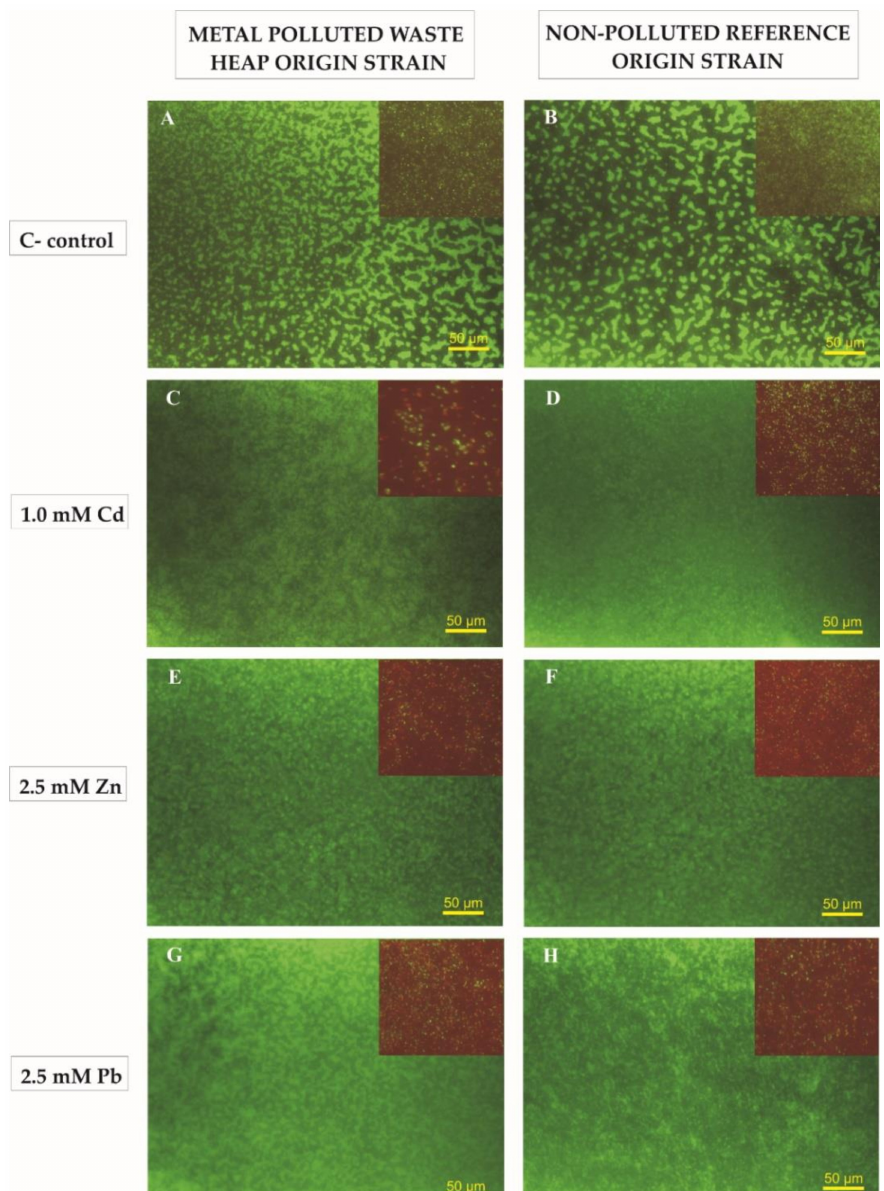
Figure 2. Biofilms structure of R. leguminosarum bv. trifolii strains originating from the metal-polluted Zn–Pb Bolesław waste heap (5.2 H) and non-polluted reference Bolestraszyce area (8.8 K) under control conditions ( A , B ) as well as under 1.0 mM Cd ( C , D ), 2.5 mM Zn ( E , F ), and 2.5 mM Pb ( G , H ) stress-stained with Syto TM 9 (a green fluorescence) and propidium iodide (a red fluorescence). Scale bar corresponds to the length of 50 µ